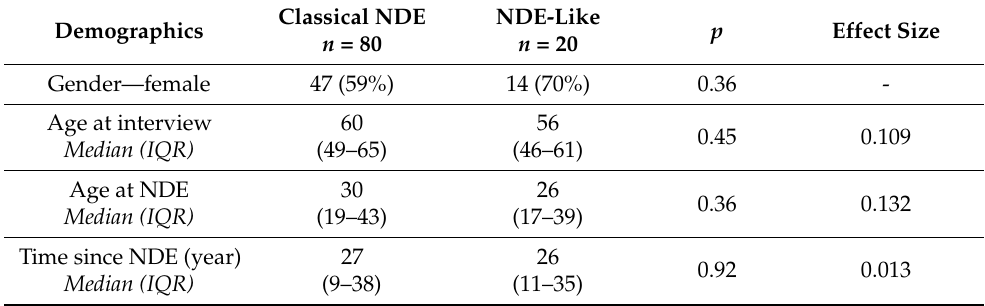
Table 1. Comparison of demographic data in the classical NDE and in the NDE-like subgroups (Pearson’s χ 2 test was used for “gender” and Mann–Whitney U tests for other